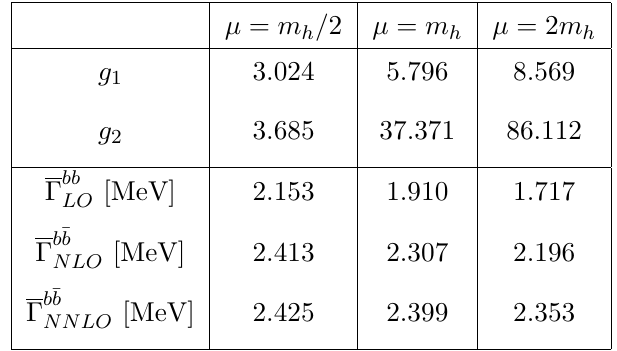
Table 2 . The coe(cid:14)cients g 1 , g 2 de(cid:12)ned in eqs. (5.1) and (5.2) and the inclusive h (125) ! b (cid:22) bX decay width at LO, NLO, and NNLO QCD for three renormalization scales (cid:22) . (cid:22) b and ^(cid:0) b is de(cid:12)ned in eq. (3.3). Our results for g 1 , g 2 , (cid:0) 0 table 2 for (cid:22) = m h = 2 ; m h ; and 2 m h . The numbers in table 2 show that the order (cid:11) 2 width by 4% for (cid:22) = m h